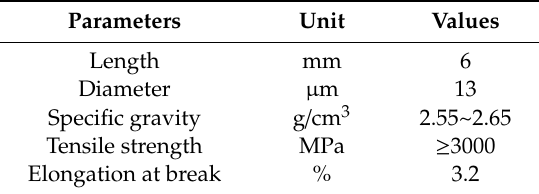
Table 5. Technical properties of basalt